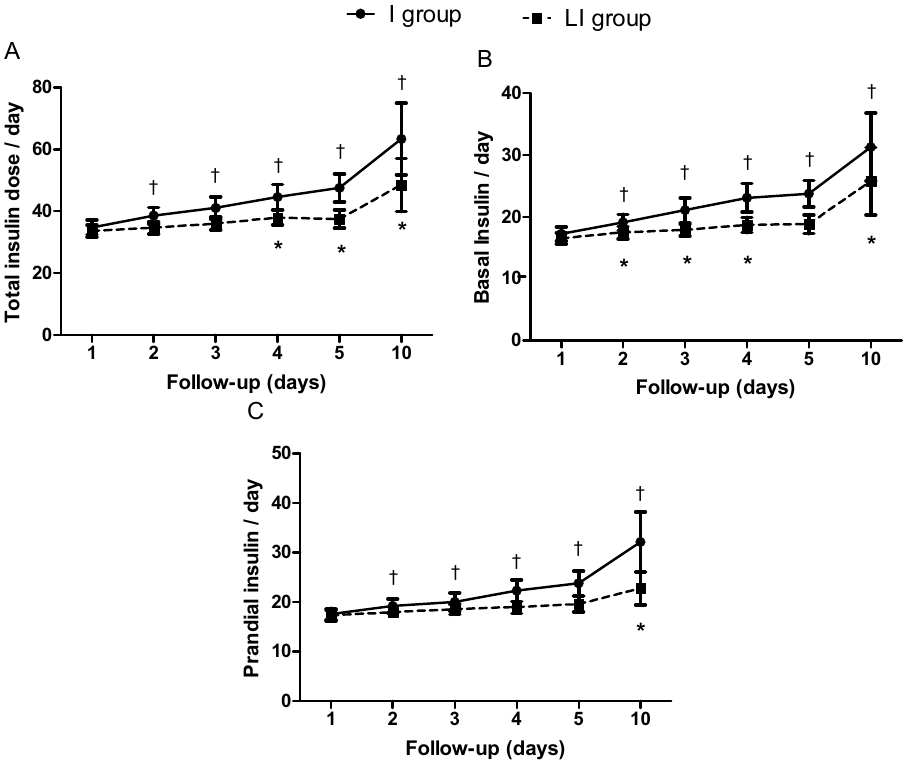
Figure 4. Total ( A ), basal ( B ), and prandial ( C ) insulin requirements between the study groups. *p < 0.05 vs day 1 in LI group ; † p < 0.05 vs day 1 in I group